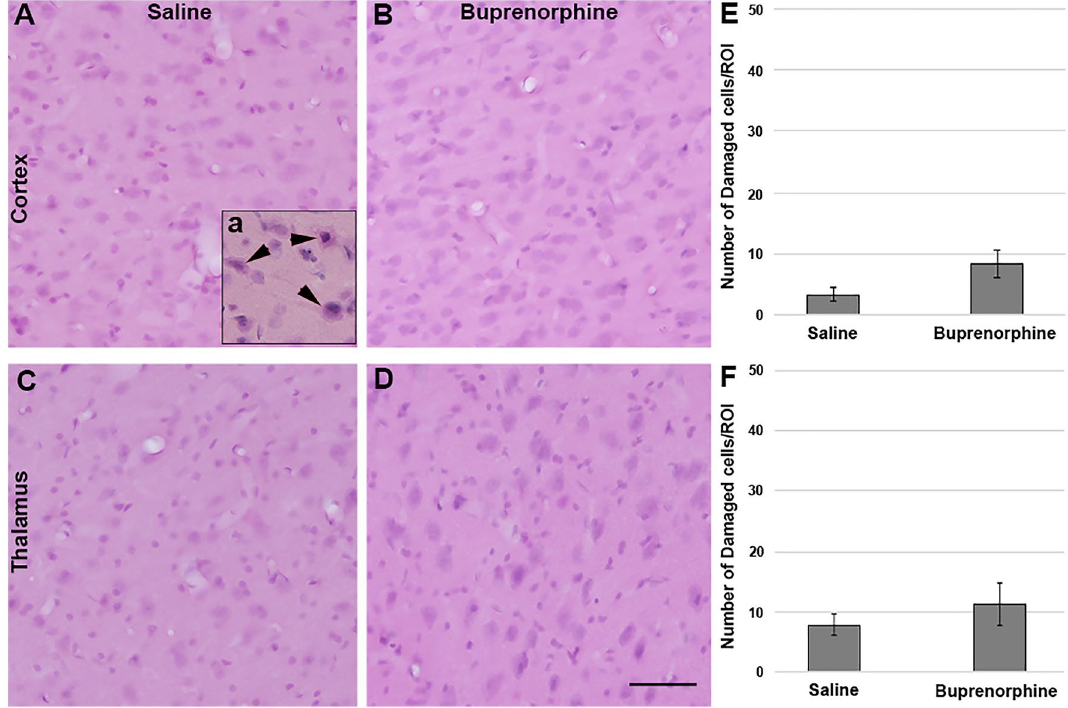
Figure 2. Cell damage was not altered by Bup treatment. Representative photomicrographs from animals treated with ( A , C ) saline or ( B , D ) buprenorphine following injury and labeled with hematoxylin and eosin (H&E) to assess cell damage and death in ( A , B) cortical and ( C , D ) thalamic regions of interest 1d post-injury. Inset a is a positive control of damaged cells demonstrating eosinophilic cytoplasm and heterochromatic nuclei. ( E , F ) Corresponding bar graphs depicting number of damaged cells per region of interest in ( E ) cortex and ( F ) thalamus. The number of damaged cells was consistent between saline and buprenorphine treated rats in both regions of interest, indicating no change in cell damage or death between treatment groups. Figure was compiled using Adobe Photoshop CS., version 22.0 (2020), San Diego, CA. n = 6 rats/group. Mean ± SEM. Scale = 50